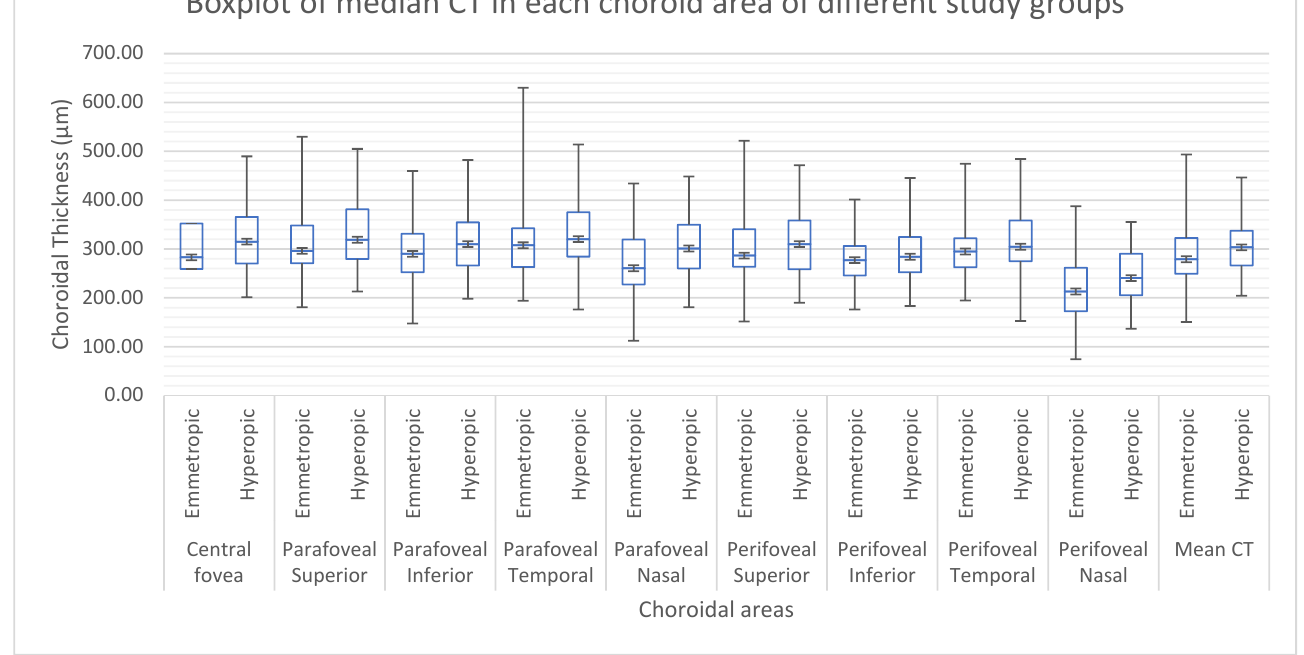
4 of 8 Table 1. Baseline characteristics of study population. Parameter